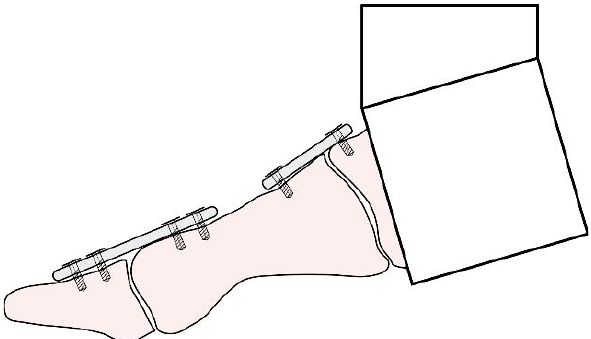
Fig. 2. PP (plate–plate)